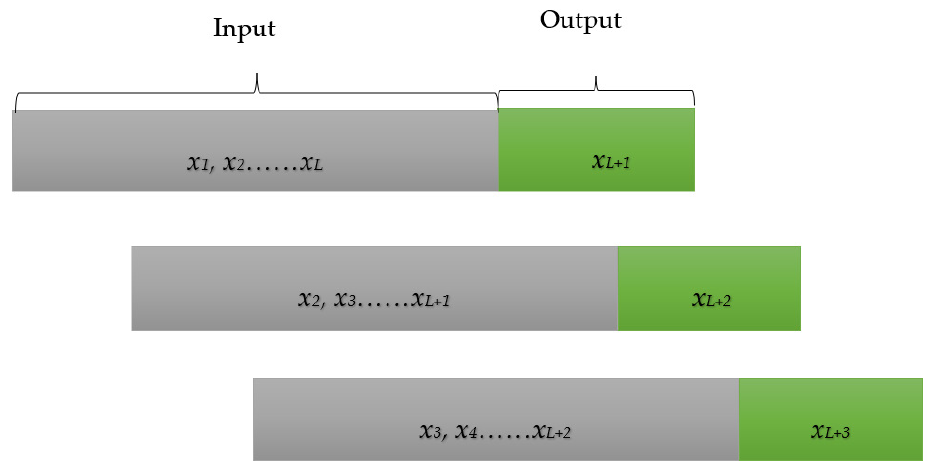
Figure 3. Rolling forecast model.